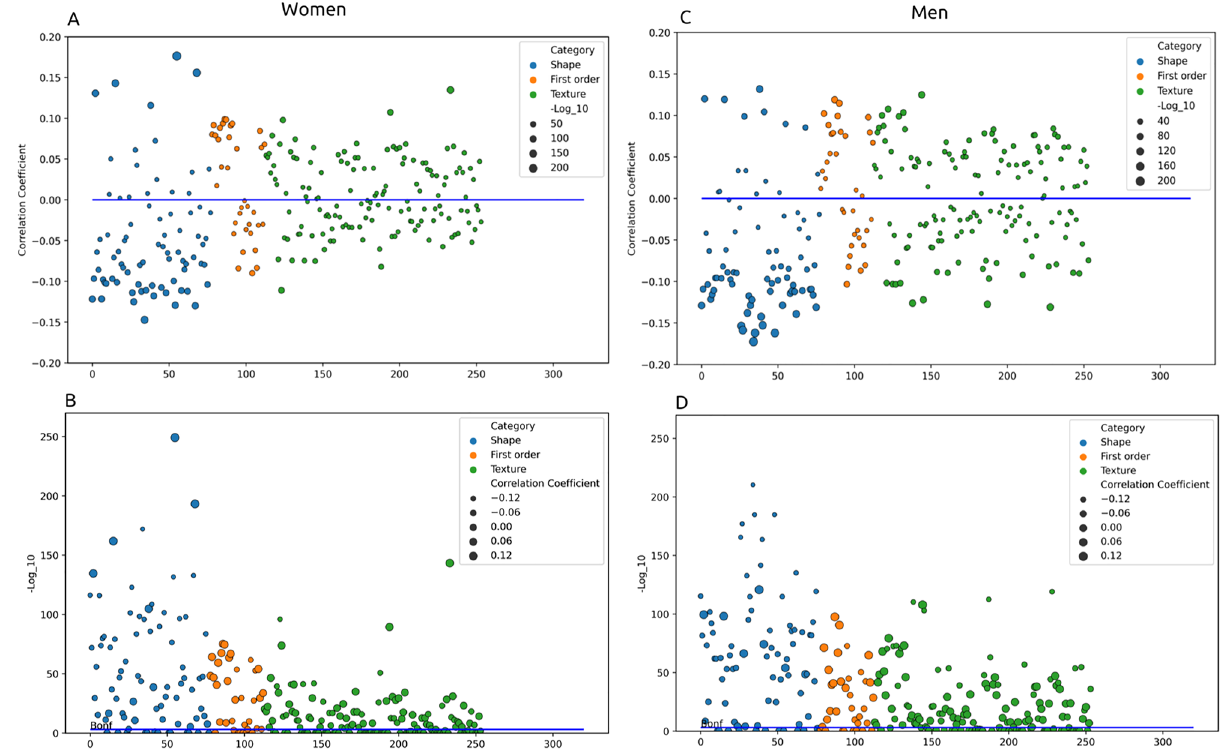
Figure 2. Association of radiomics features with heart age. Each circle represents an individual radiomics feature. The blue, orange, and green circles indicate individual radiomics shape, first order, and texture features respectively. Correlation coefficients are from Pearson correlation of radiomics features against heart age. The p-values are corrected for multiple testing and converted to − log10, so larger values indicated smaller (more significant, p-value * 254 < 0.05) values. ( A and B ) are the results for women. ( C and D ) are the results for men. ( A and C ) The distance of each circle from the blue line indicates the magnitude of the correlation coefficient (as per y-axis) with heart age. The size of the circles reflects magnitude of the p-value with larger circles indicating smaller p-values. ( B and D ) The distance from the blue line indicates size of the p-value (level of significance) and the size of the circle indicates magnitude of the correlation coefficient. Horizontal line depicts the Bonferroni threshold of significance (p-value * 254 < 0.05) for multiple comparisons (a =